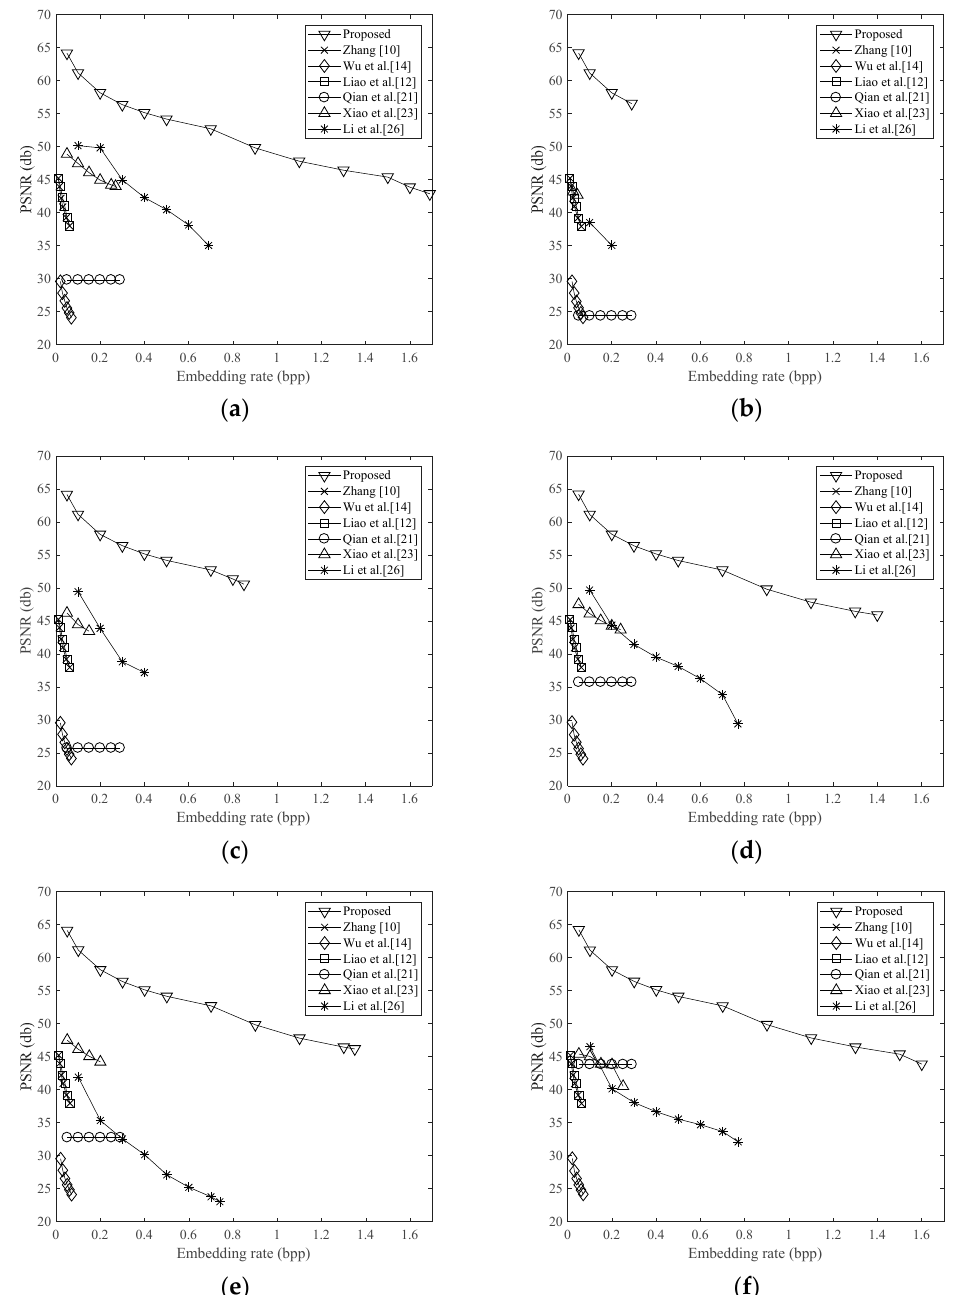
Figure 8. Comparison of the PSNR values: ( a ) Airplane; ( b ) Baboon; ( c ) Barbara; ( d ) Lena; ( e ) Peppers; ( f ) Zelda.